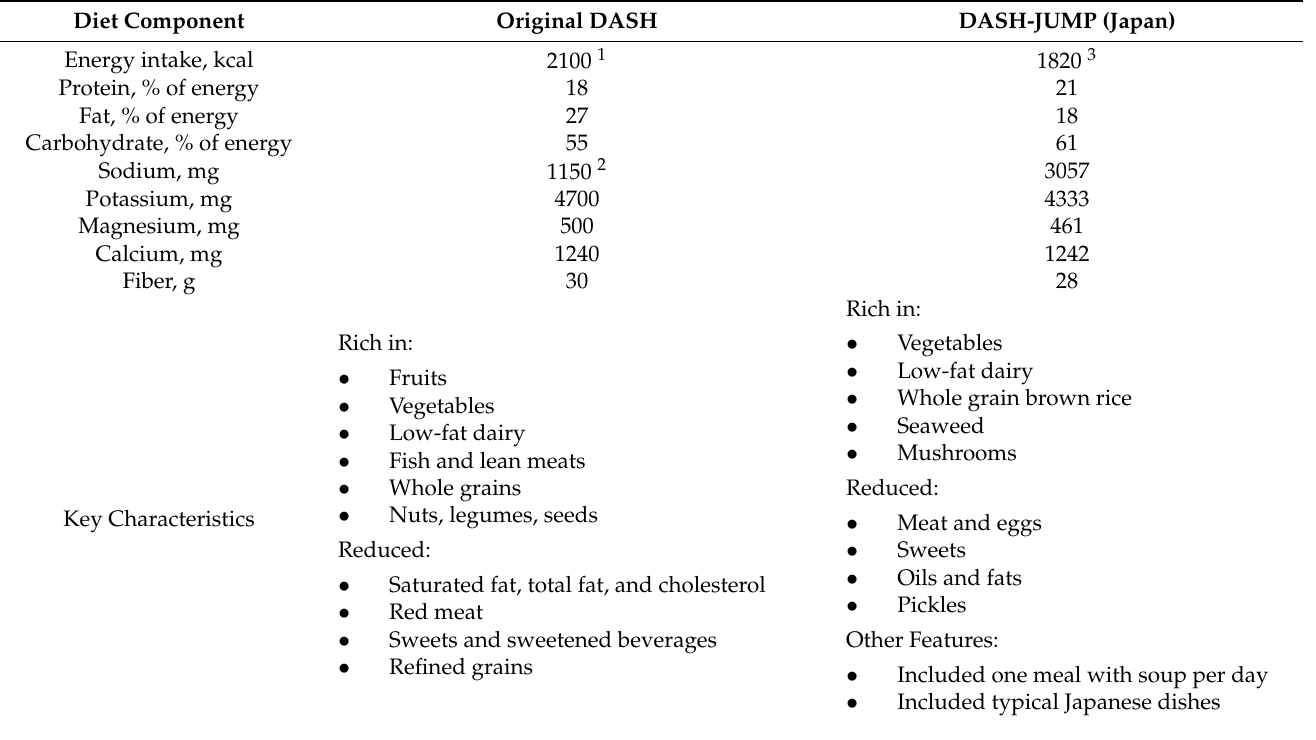
Table 2. Comparing the original DASH diet to the Japanese DASH